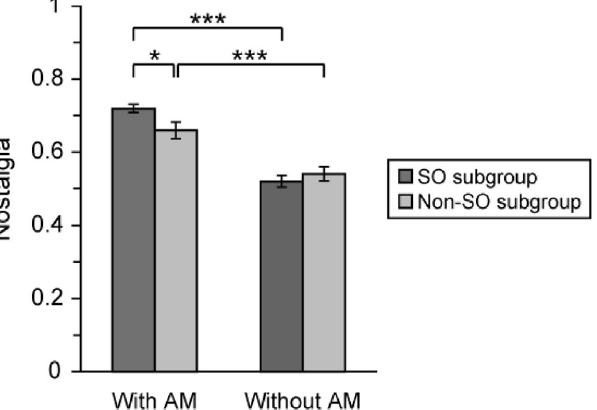
Figure 4. Nostalgia for nostalgic vegetable with and without autobiographical memories in each seasonality subgroup. Nostalgia for nostalgic vegetables with and without associated autobiographical memories in the SO and non-SO subgroups. Two-way factorial ANOVA revealed a significant interaction between seasonality subgroup and autobiographical memory ( F (1, 682) = 4.38, p < 0.05). AM: autobiographical memory. Error bar: SE. *** p < 0.001, ** p < 0.01, * p <